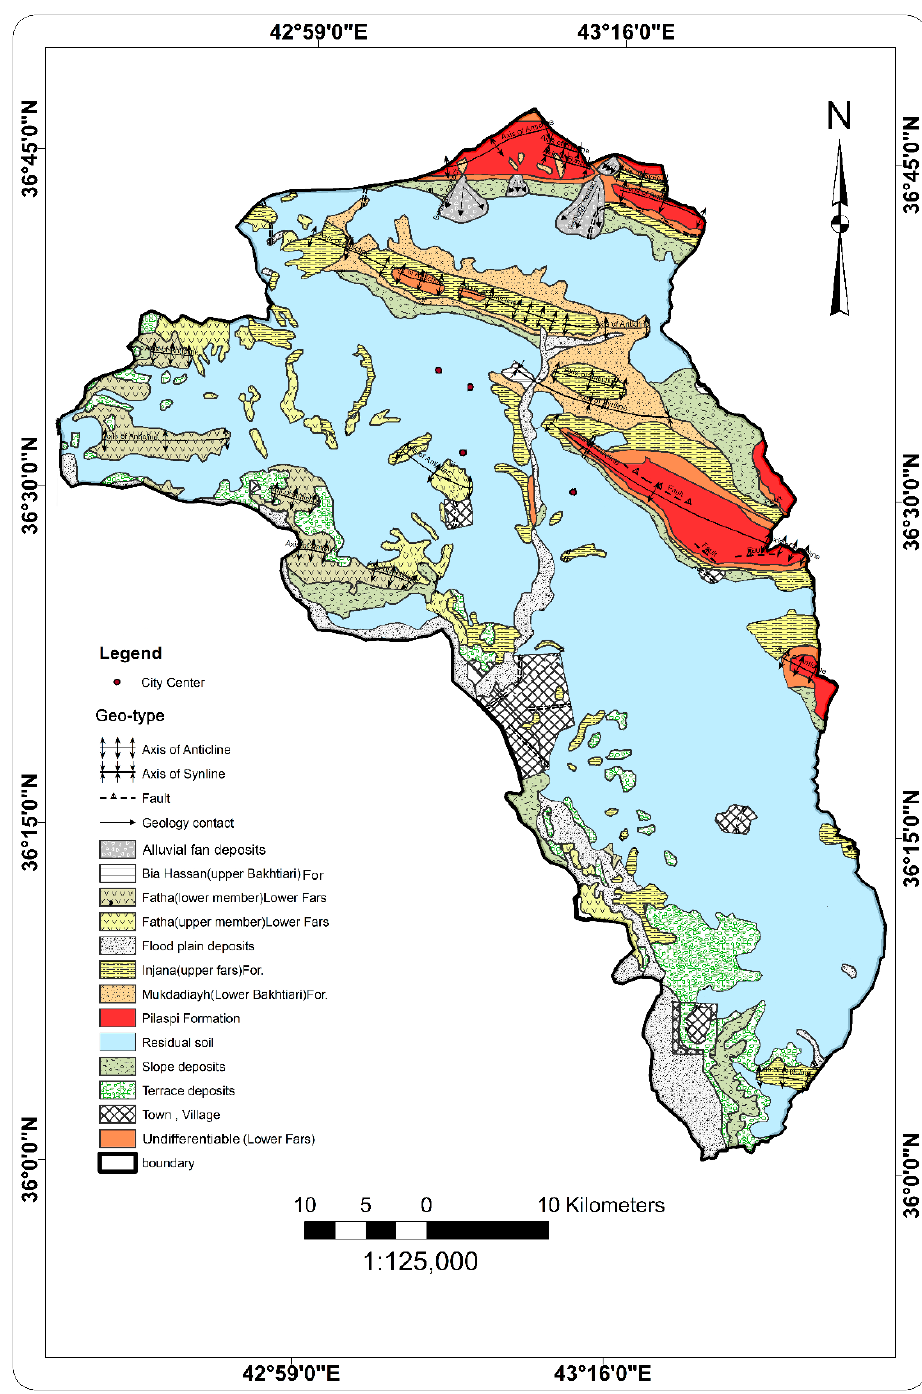
Figure 1. Location and topography of the study area.